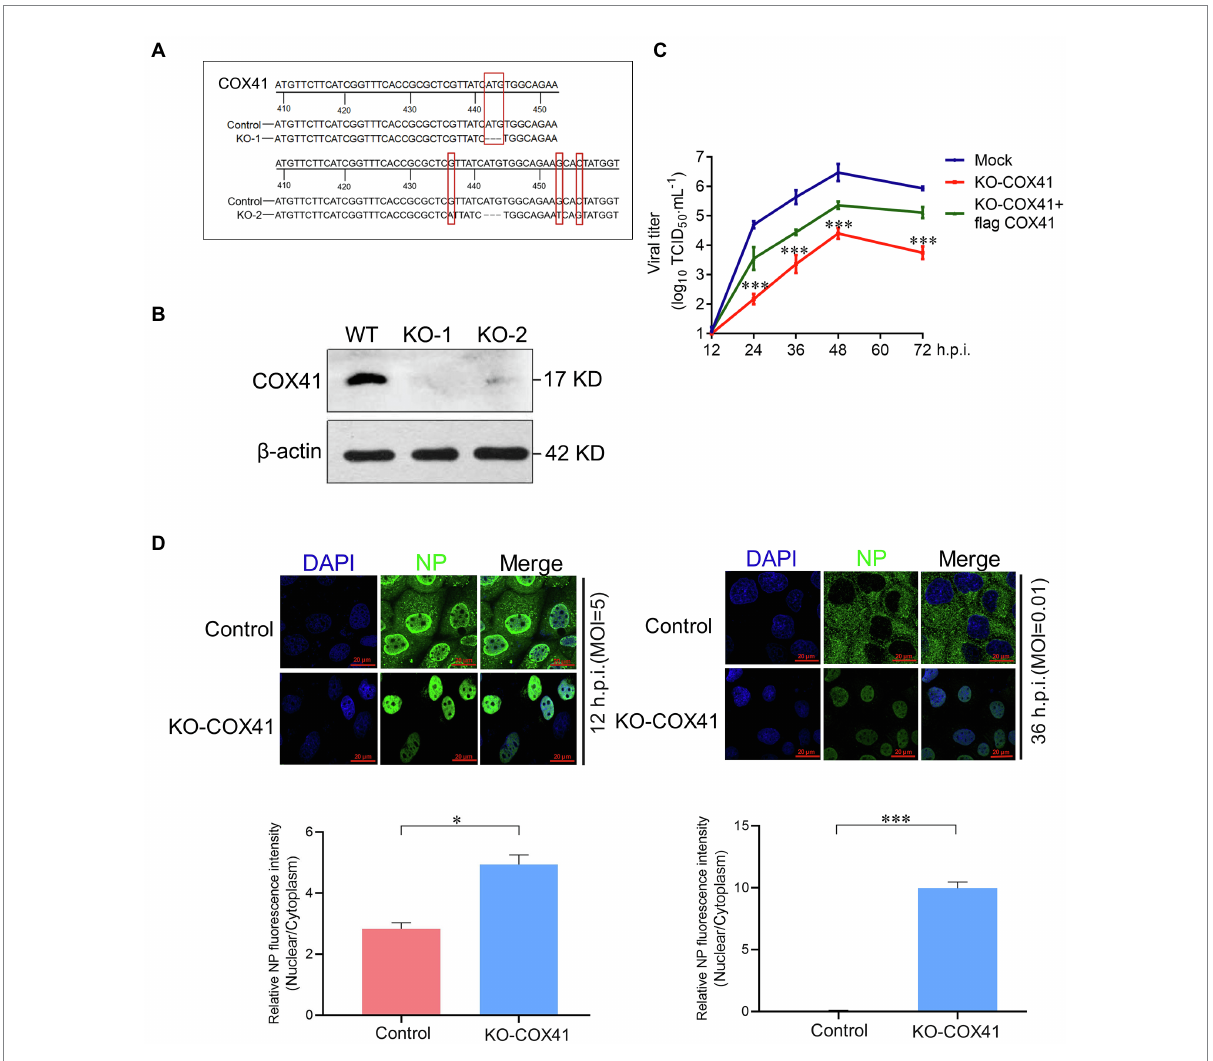
FIGURE 2 Cytochrome c oxidase subunit 4 isoform 1 (COX41) was involved in the nuclear export of vRNP. (A) Generation of COX41-defective HEK 293T cells. (B) The levels of COX41 in COX41-defective HEK 293T cells were determined by western blot assay. (C) Growth kinetics of the H5N1 (MOI, 0.01) in wild-type (WT) cells, COX41-KO-1 cells, and COX41-KO-1 cells with transfection of Flag-COX41. The supernatants in HEK293T cells were collected at 12, 24, 36, 48, and 72 h postinfection and subjected to viral titer determination by TCID 50 assays. Data are mean ± s.d. ( n = 3). *** p < 0.001. (D) WT and KO-1 cells were infected with H5N1 (MOI, 5 for 12 h.p.i. and MOI = 0.01 for 36 h.p.i.) after 1 h of adsorption. After infection, subcellular localization of NP was detected using a confocal microscope. Mean fluorescence intensity associated with NP expression level was analyzed by Image J software. Data are mean ± s.d. ( n = 3 ~ 5). * p < 0.05; *** p <